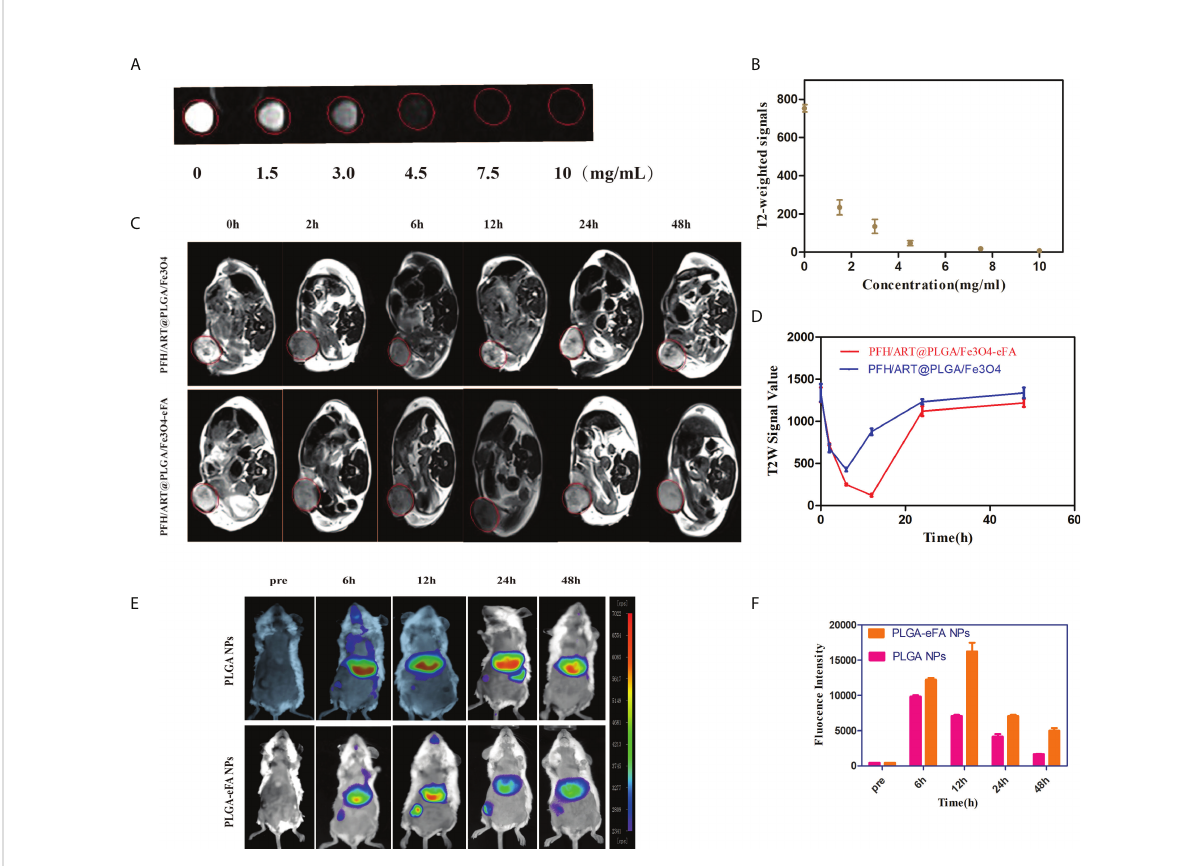
FIGURE 4 In vivo tumor accumulation and biodistribution of NPs. (A) In vitro MRI signal intensity of PFH/ART@PLGA/Fe PFH/ART@PLGA/Fe 3 O 4 -eFA at different concentrations (0, 1.5, 3, 4.5, 7.5, and 10 m g/mL). (B) In vitro MRI signal intensity curve of different concentrations of PFH/ART@PLGA/Fe 3 O 4 -eFA. (C) The MRI T2-weighted imaging signal intensity of 4T1 tumor-bearing mice injected with